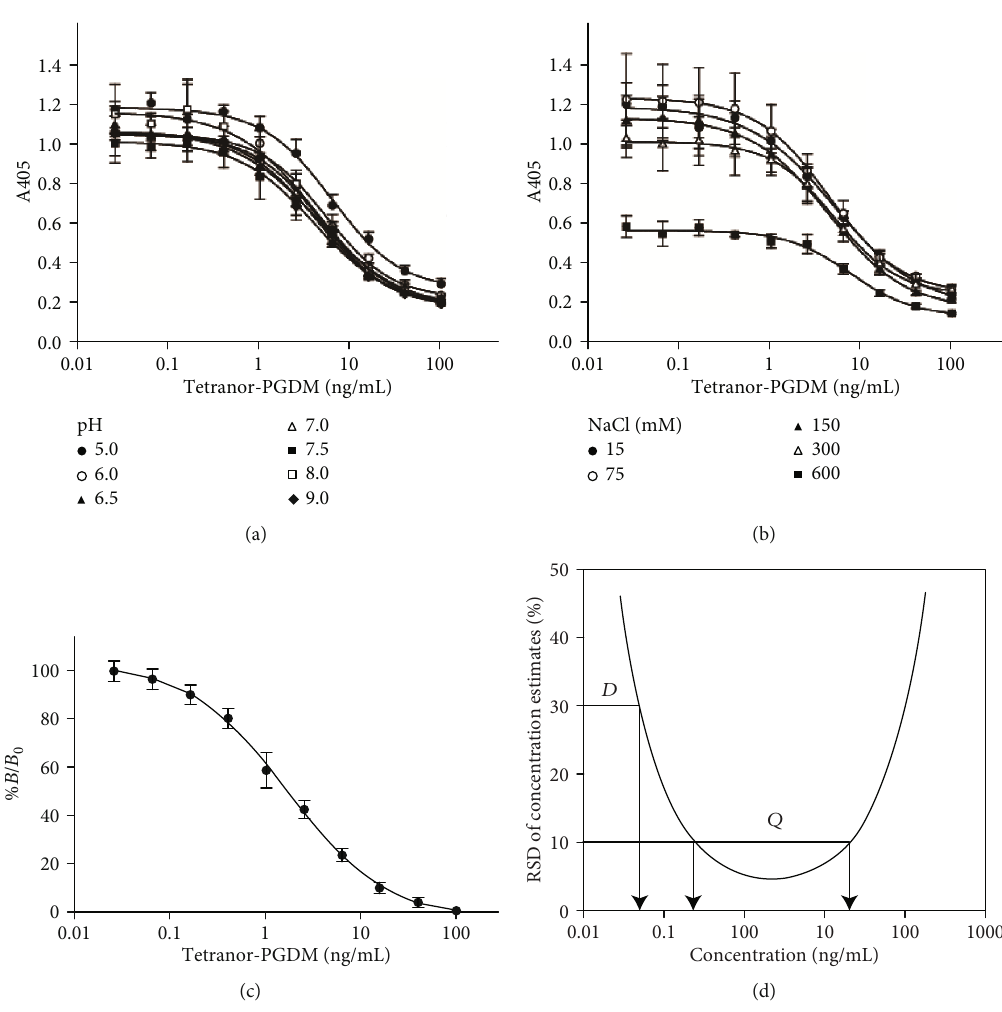
Figure 1: Optimization of competitive EIA. E ff ects of pH value (a) and ionic strength (b) on assay bu ff er on performance of EIA. (c) Inhibition curve for tetranor-PGDM under the optimized conditions. (d) Detection limit and quantitation range for tetranor-PGDM. Arrow D : the detection limit; arrow Q : the lower and upper limits of quantitation range. Table 1: Precision of the proposed EIA for tetranor-PGDM measurement at di ff erent concentration